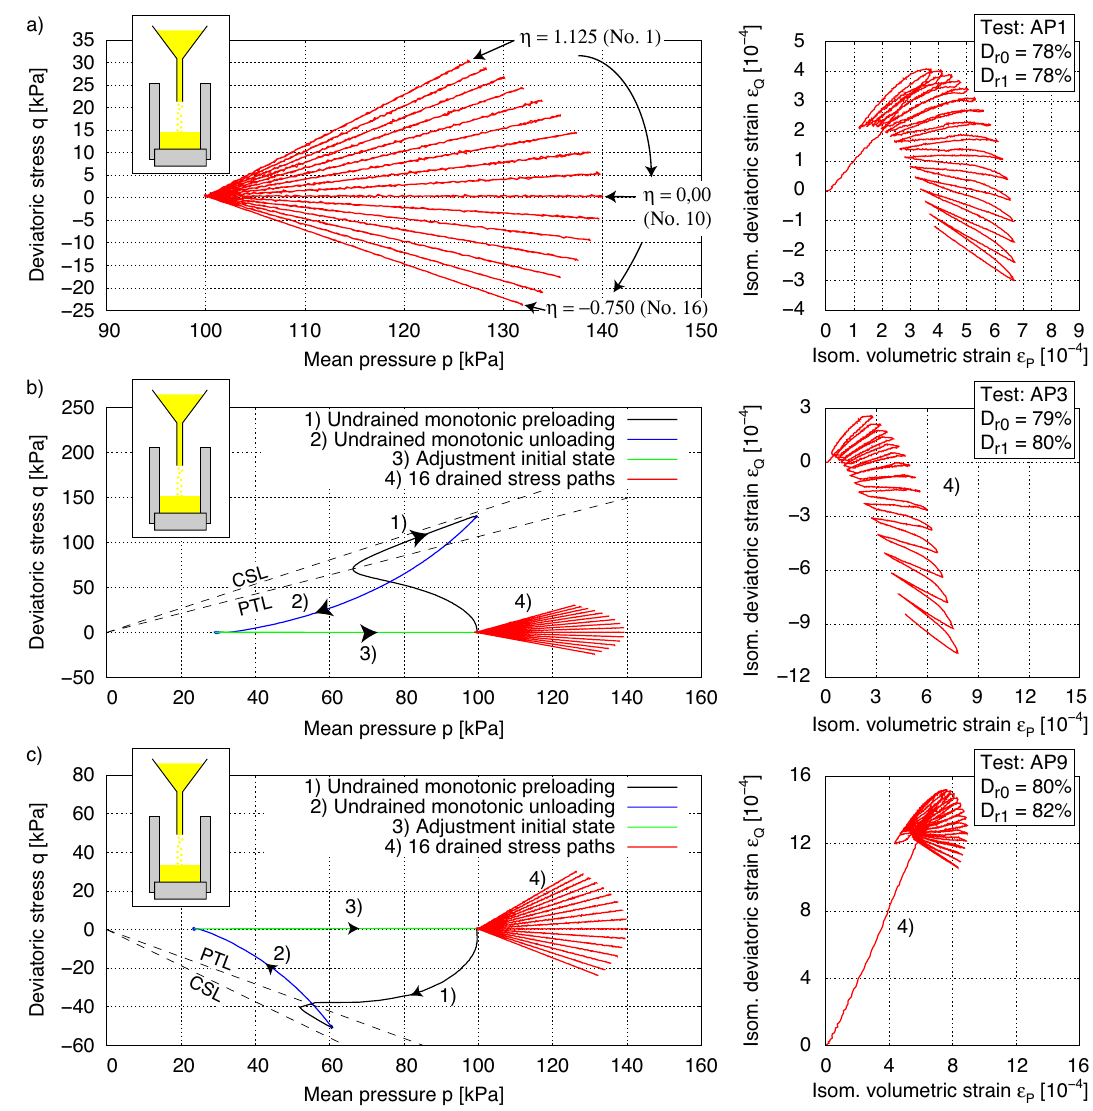
Figure 6. Test results on KFS with a critical friction angle ϕ c = 33.1 ◦ : ( a ) without preshearing history of Test AP1 as reference test, ( b ) preshearing history in compression area of Test AP3 with mobilized friction angle ϕ mob = 32.4 ◦ and ( c ) preshearing history in extension area of Test AP9 with mobilized friction angle ϕ mob = 29.1 ◦ . D r 0 after sample preparation (air pluviation) and D r 1 at start of drained stress